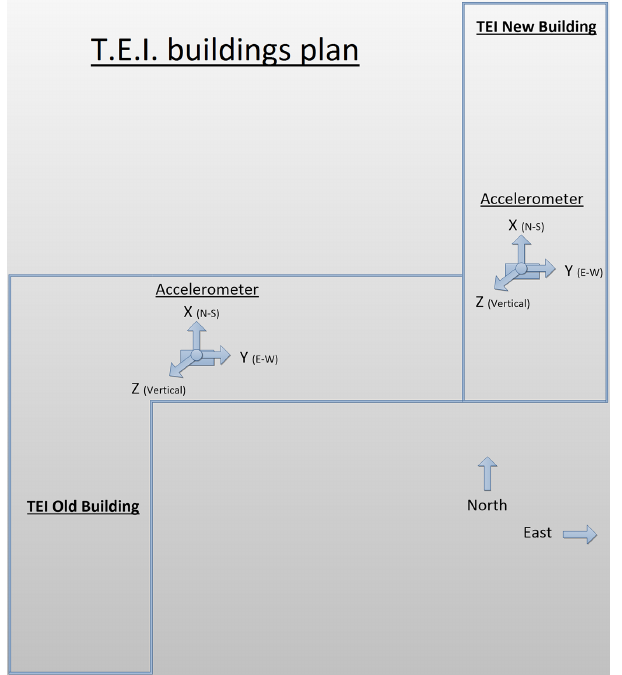
Figure 3. Schematic plan of the TEI building at Chania. The loca- tion of the sensors is presented for each